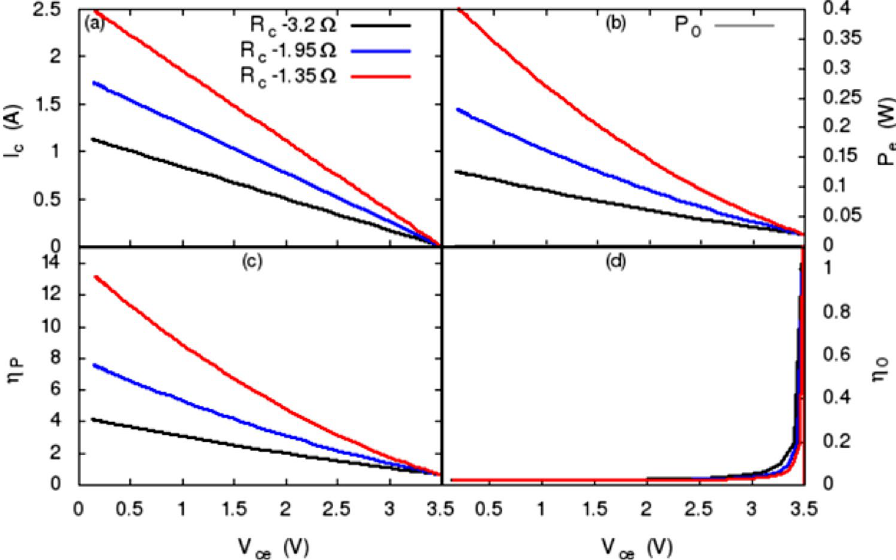
Figure 7. Performance of the new thermoelectric leg. ( a ) Load lines of the amplifier obtained for three R c s. ( b ) Power generated by the thermoelectric leg. P 0 power produced solely through Seebeck effect. ( c ) Power gain rate. ( d ) The effectiveness of the new thermoelectric leg. The parameters of the thermoelectric leg and the amplifier used to obtain these results are given in the